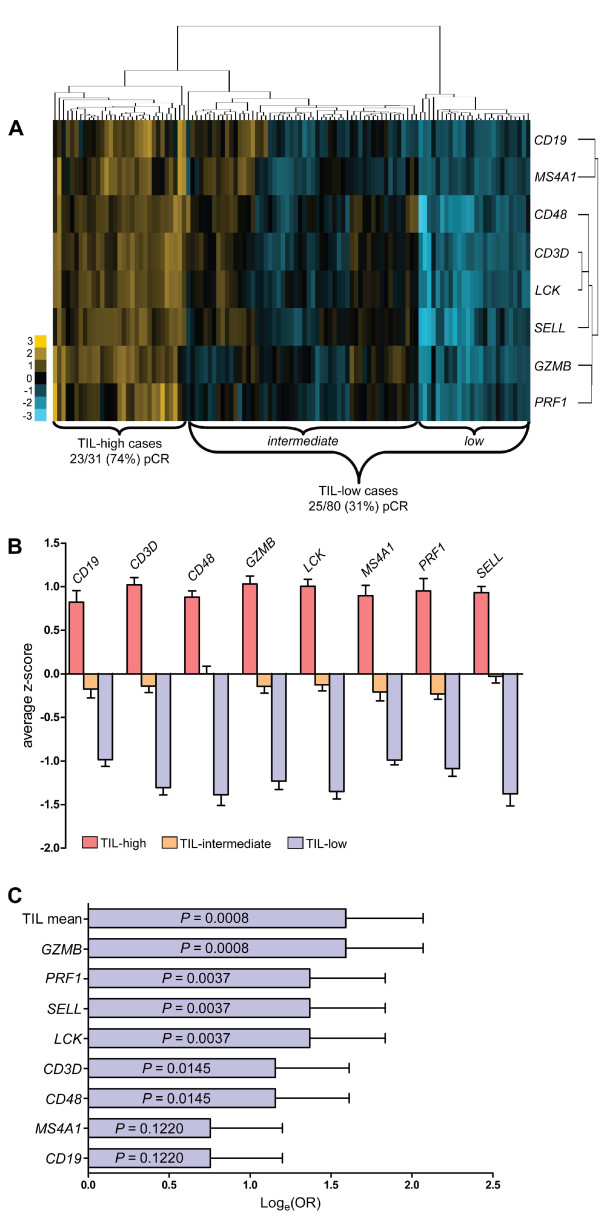
An eight-gene tumor infiltrating lymphocyte (TIL) signature is associated with pathologic complete response (pCR) after neoadjuvant chemotherapy in the EORTC cohort. (a) Heat map displaying gene (y-axis) and case clusters (x-axis). The TIL-high and TIL-low groups with respective rates of pCR are indicated. Colors correspond to z-normalized expression levels. (b) Average expression levels ±SEM of each gene in the three primary centroids. (c) Odds ratios (loge transformed, ±SEM) for probability of pCR derived from Fisher's exact tests for each gene in the TIL signature. The TIL mean represents average expression levels across all eight genes. High and low gene expression categories were assigned using the upper quartile as the cut-point.